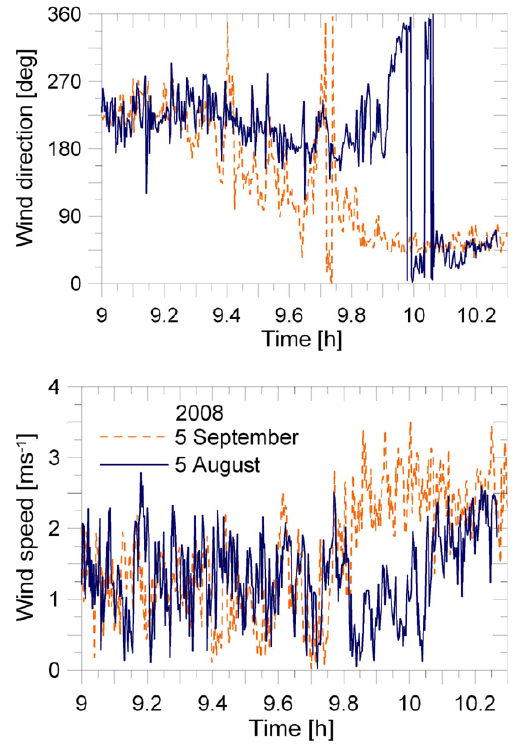
Figure 5. The sharp onset of the sea breeze on 5 August 2008 (dark blue solid lines) and 5 September 2008 (orange dashed lines) in wind direction (upper panel) and wind speed (lower panel) based on the 10-s data.